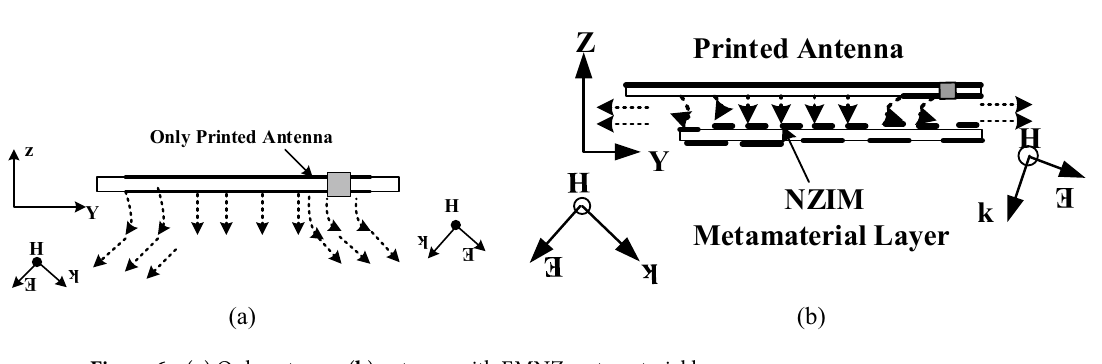
Figure 6. ( a ) Only antenna, ( b ) antenna with EMNZ metamaterial